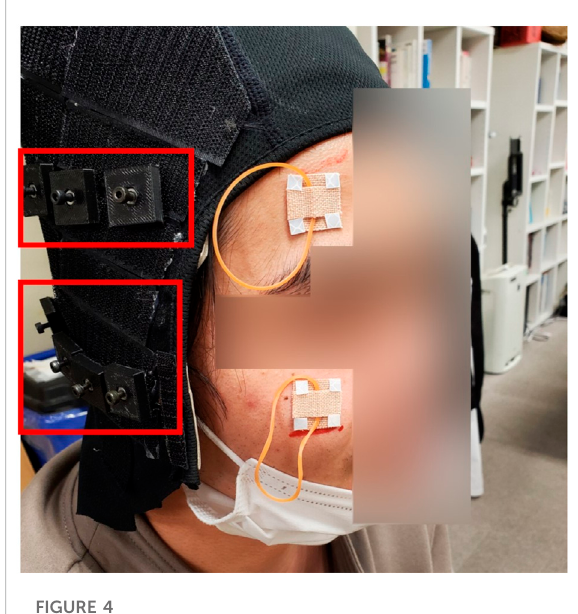
A participant wearing the experimental device. (Fixation devices are shown in red